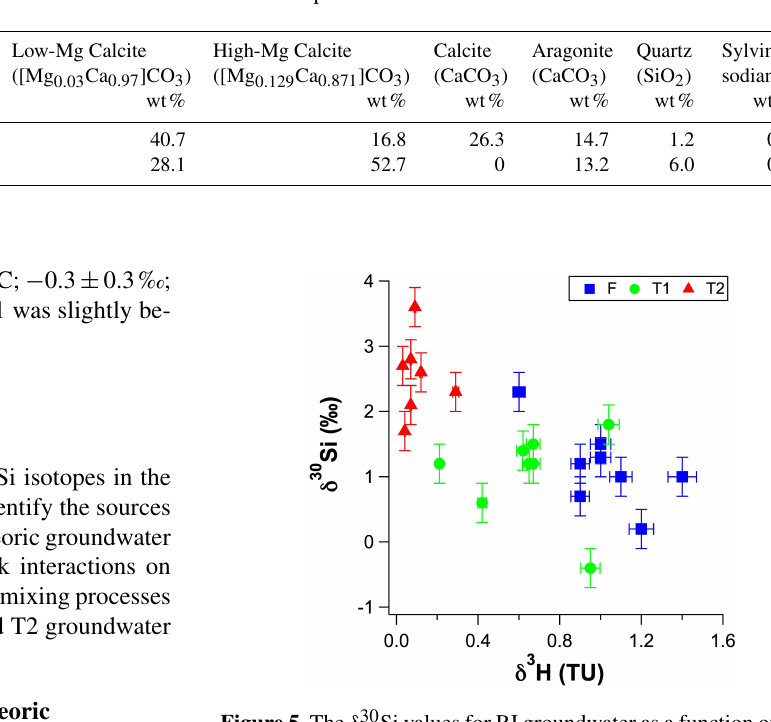
Figure 5. The δ 30 Si values for RI groundwater as a function of their 3 H concentrations (in tritium units –